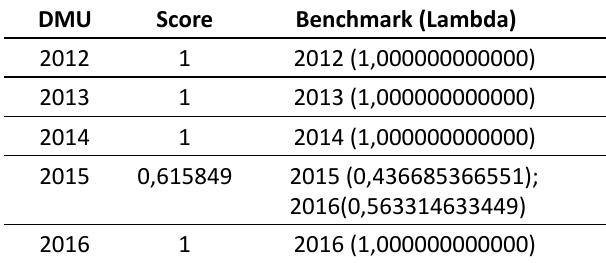
Table 2: Results of Efficiency Analysis Using DEA with (intput Oriented) DMU